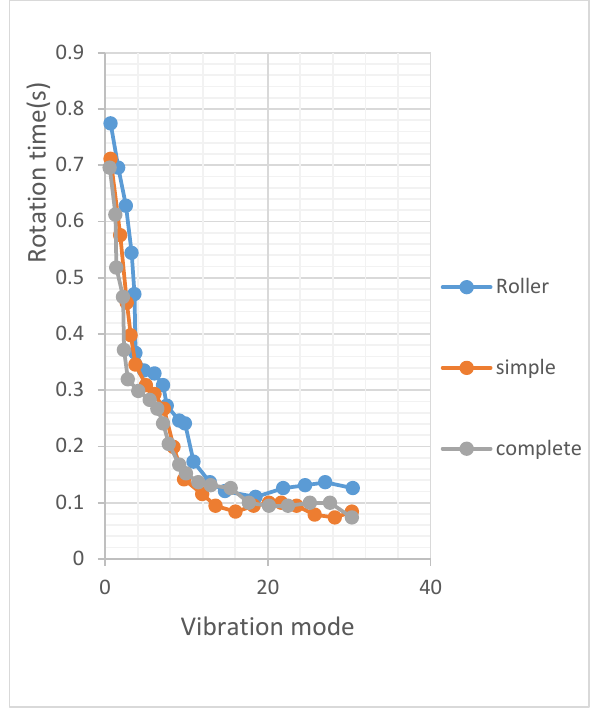
Fig. 9. Six- span bridge with a base height of 8 meters.